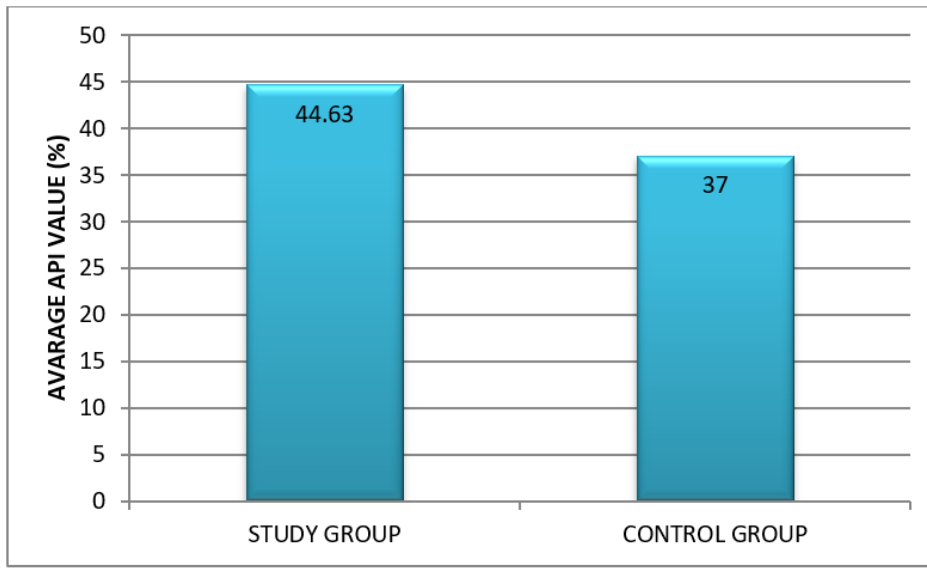
Figure 1. Oral hygiene assessment based on API in the study and control group.